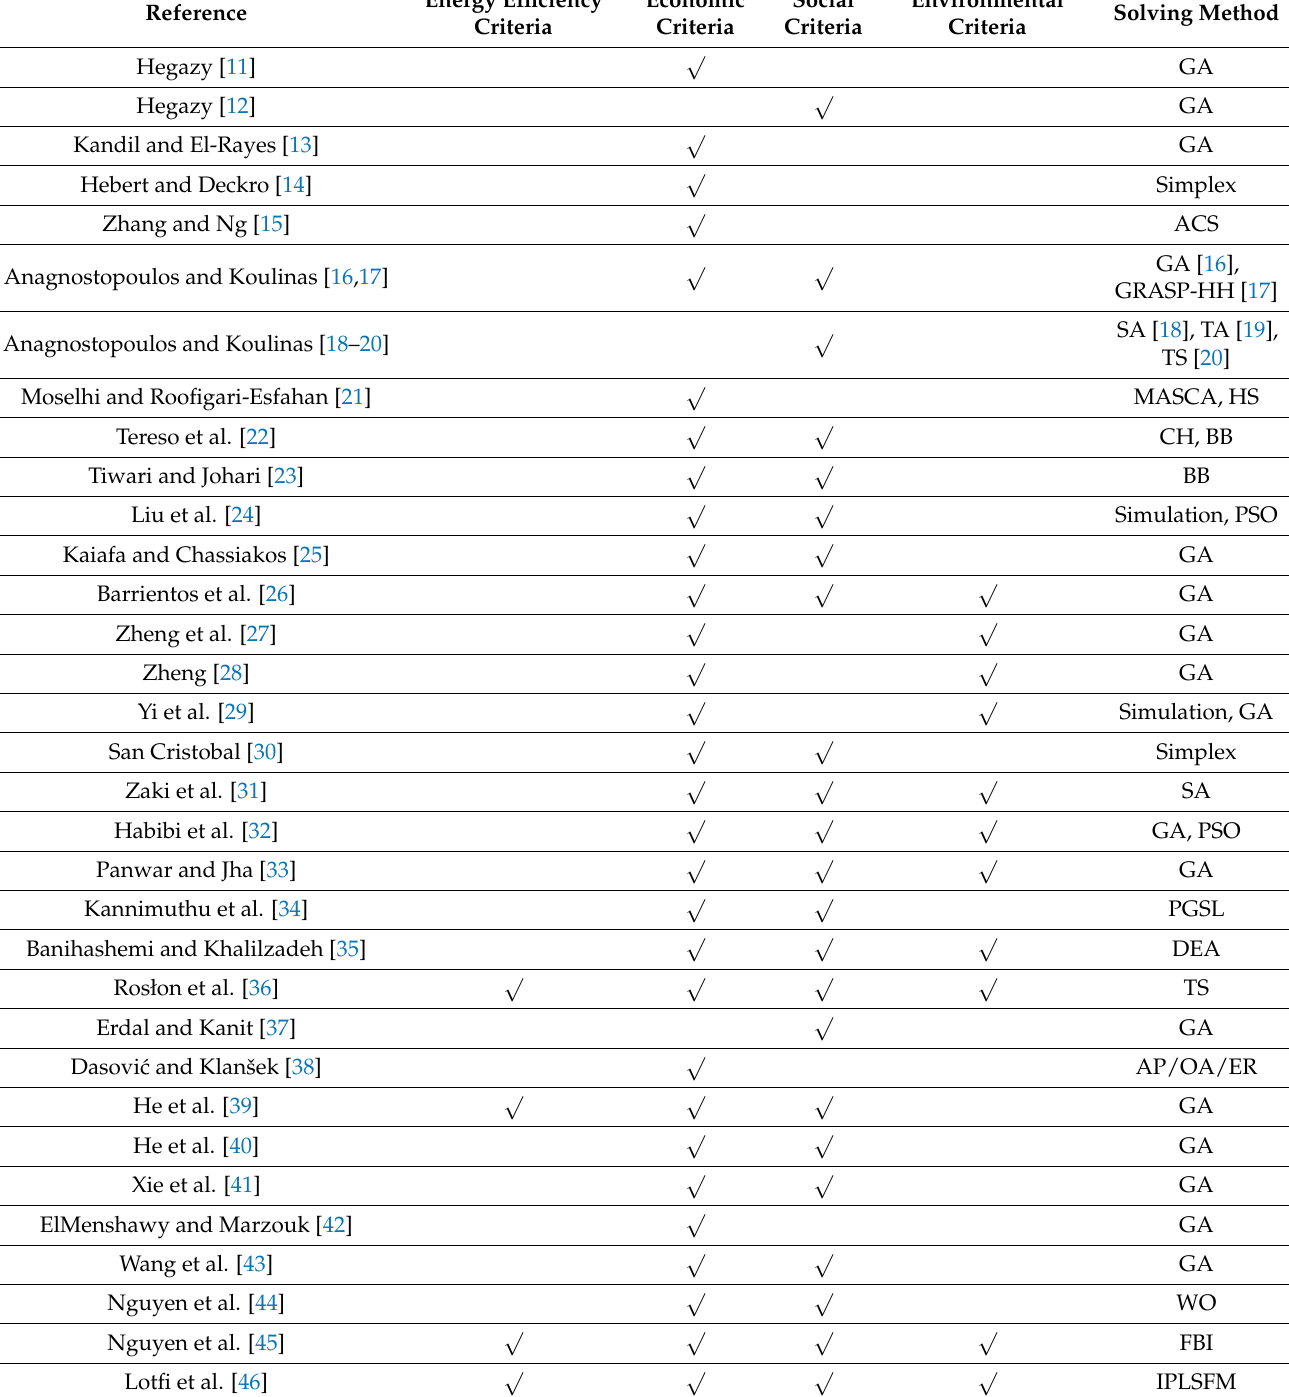
Table 2. Summary of accomplishments in energy-efficient and sustainable construction